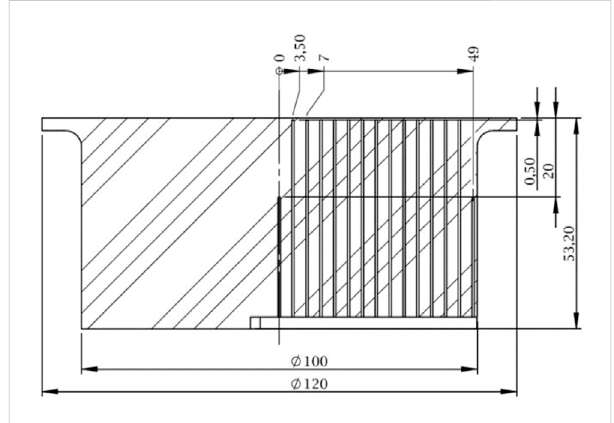
FIGURE 3 Sectional view of the heated target showing the thermocouple positions. Dimensions are in